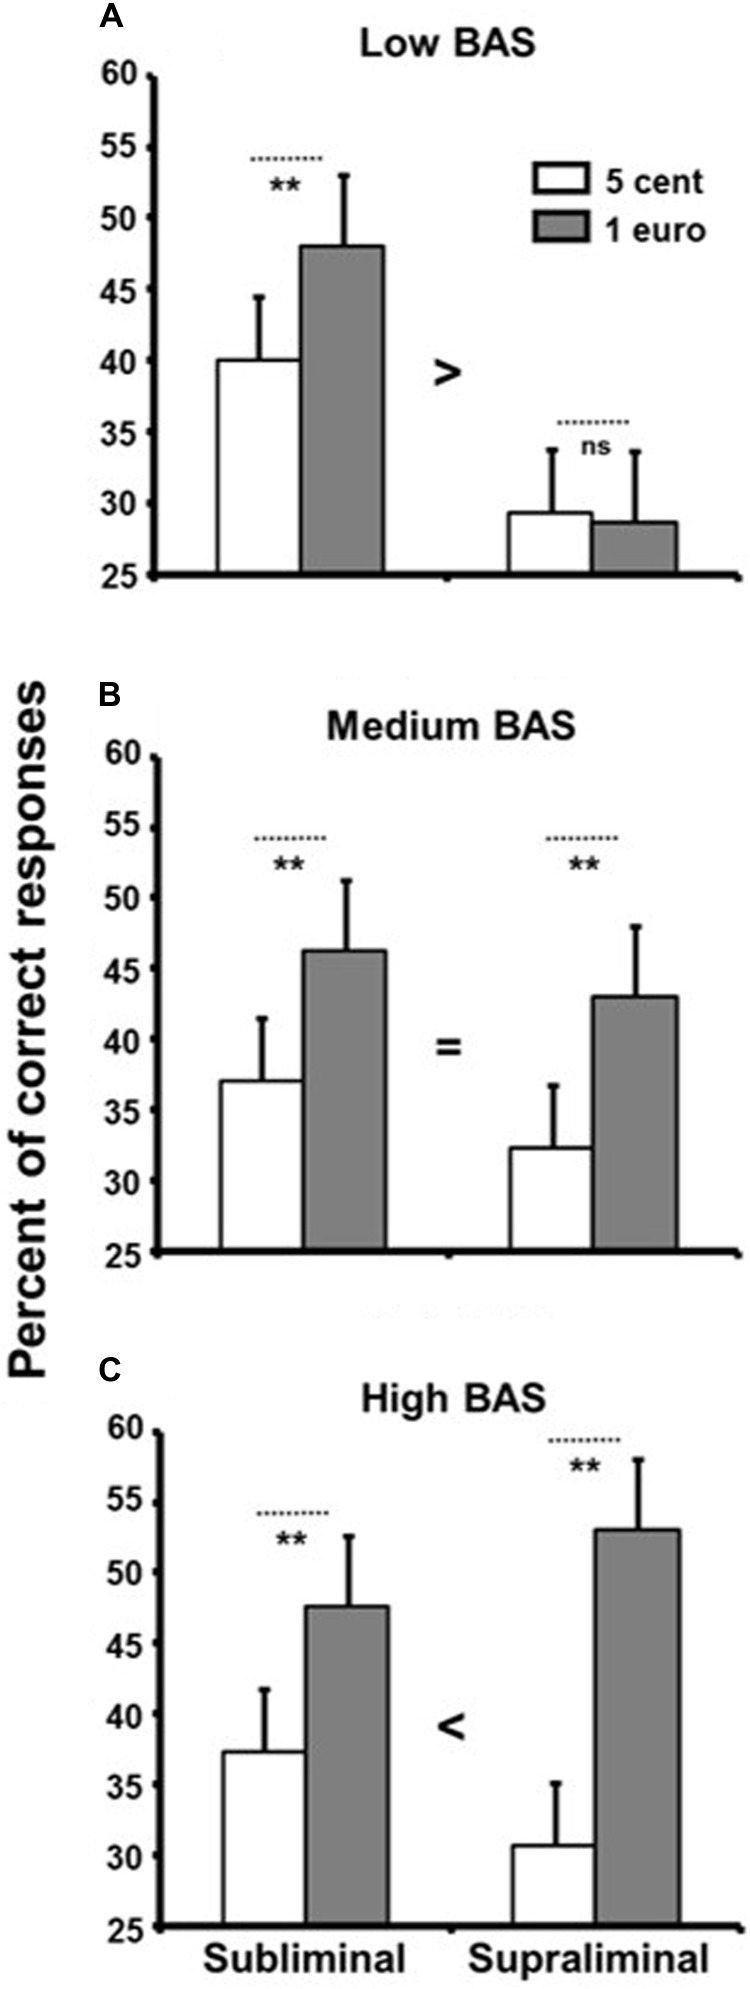
Percentage of correct responses in the memory-updating task as a function of reward value displayed subliminally and supraliminally and BAS groups. Low BAS participants (A) performed better for the high reward than the low reward only in the subliminal condition. In the medium BAS group (B), there was a main effect of reward, and it was similar in the subliminal and supraliminal conditions. In the high BAS group (C), the reward effect was higher in the supraliminal condition than the subliminal condition. Error bars denote standard errors of the mean. ∗∗p < 0.005, and ns for not significant.